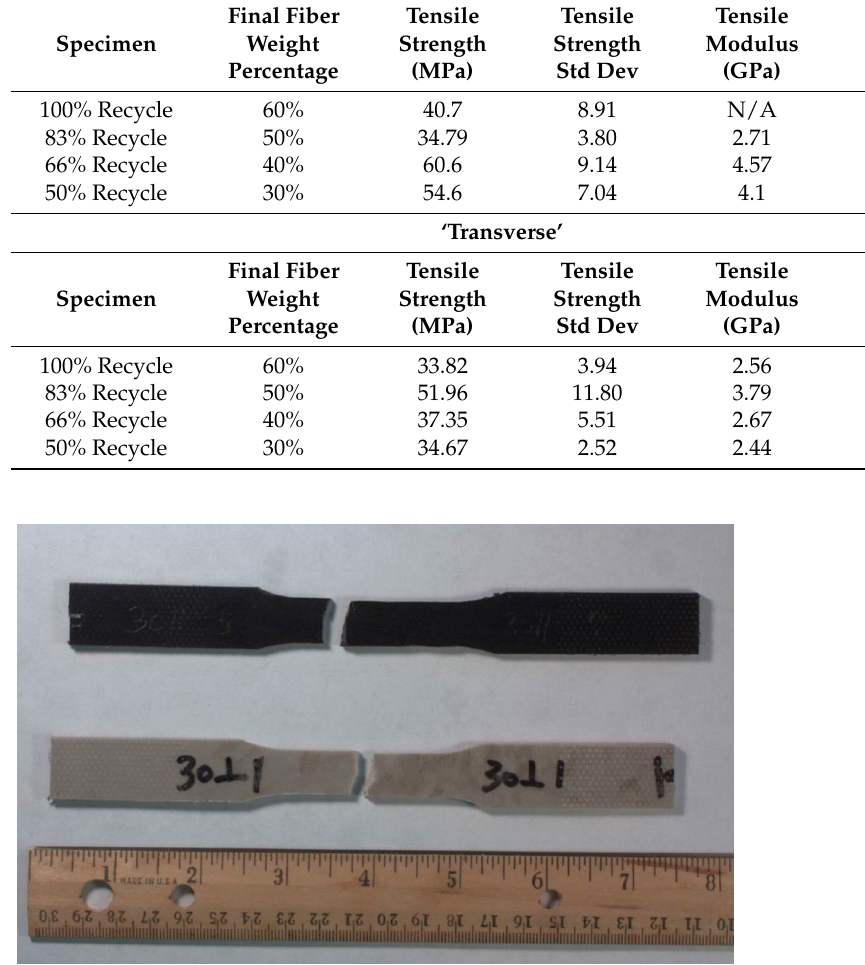
Figure 9. Tensile failure of ( top ) 30 wt% recyclate GF-PP and ( bottom ) 30 wt% LFT GP-PP failure modes.